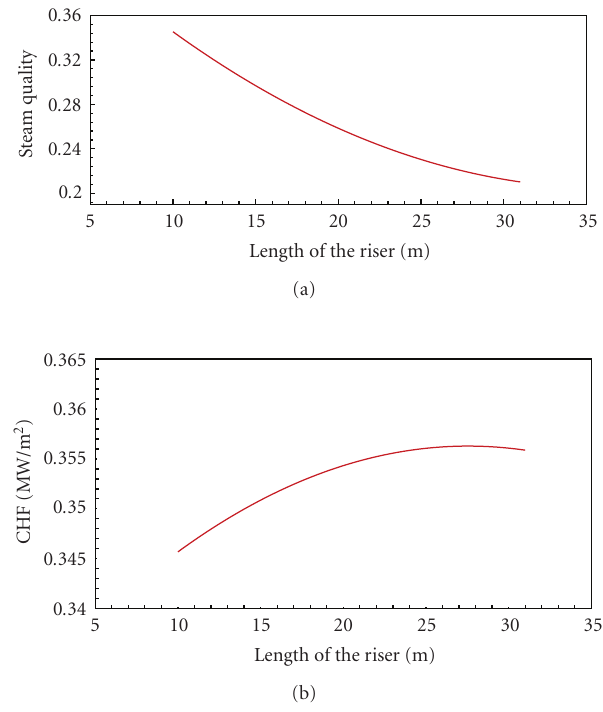
Figure 13: The variations of (a) steam quality and (b) CHF with core